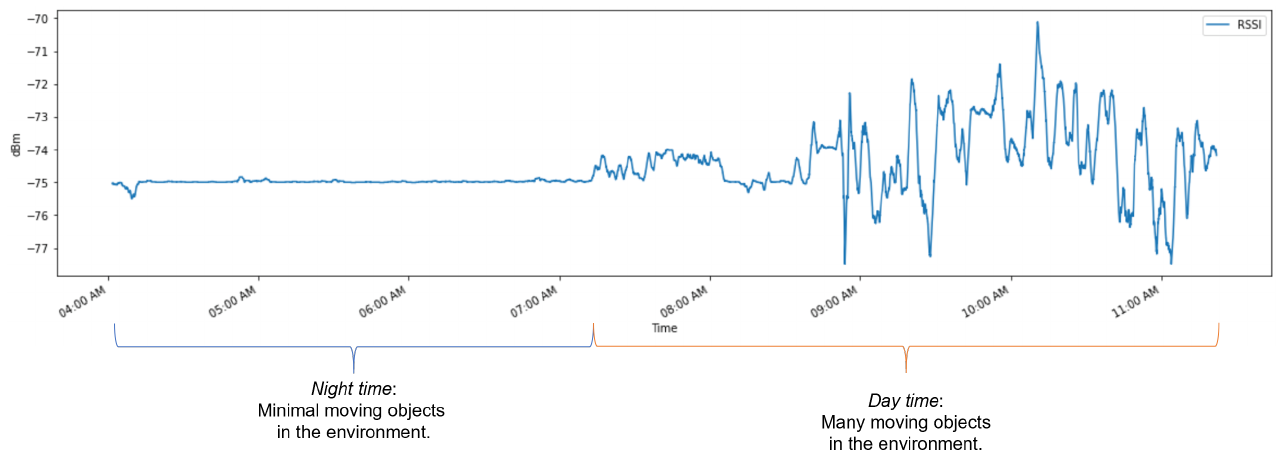
Figure 8. s ’ RSSI stream received by r during s ’ deployment outside of the